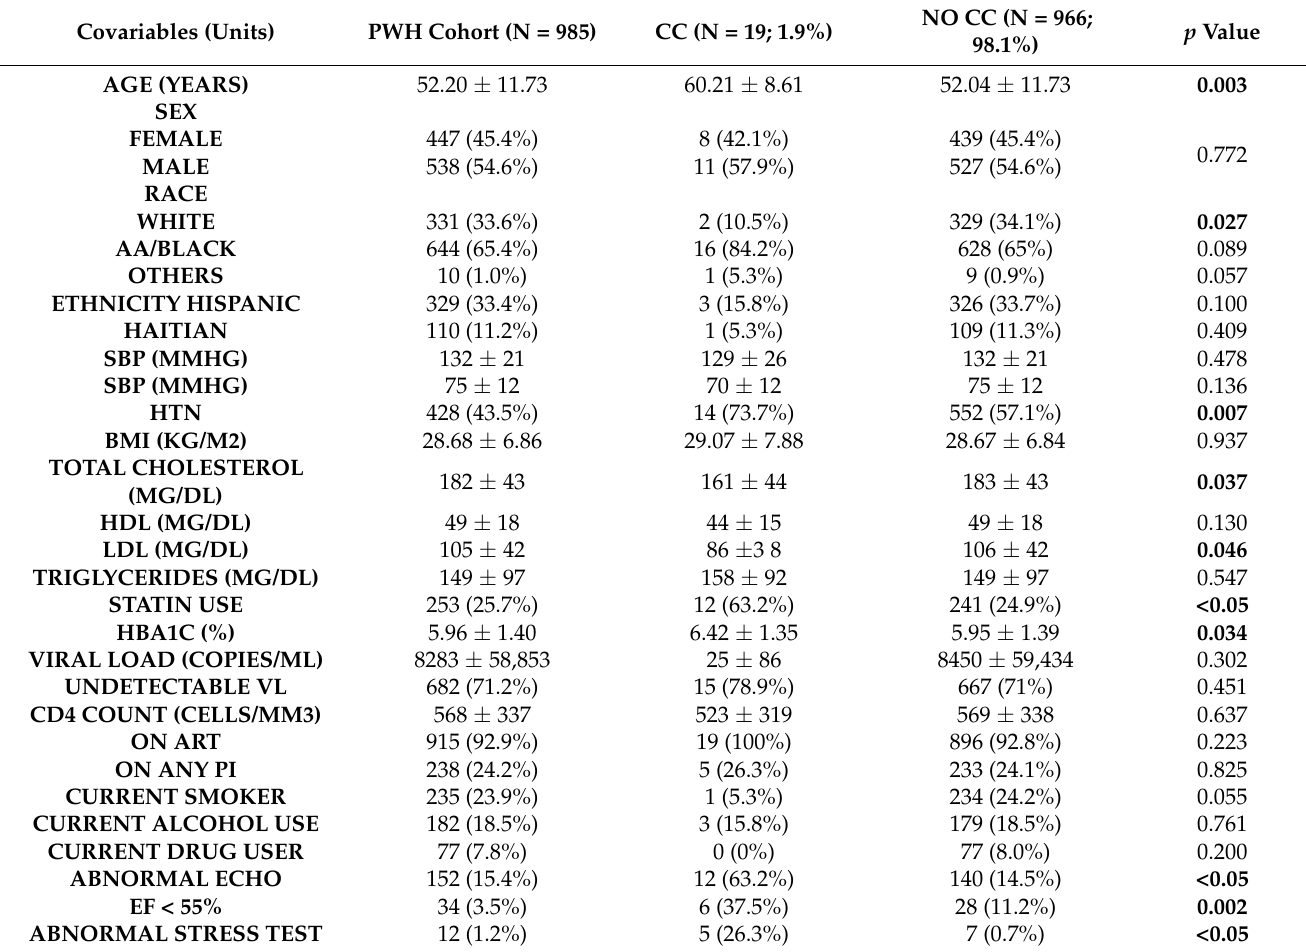
Table 1. General data of the entire cohort and comparison of patients undergoing CC vs. non-CC